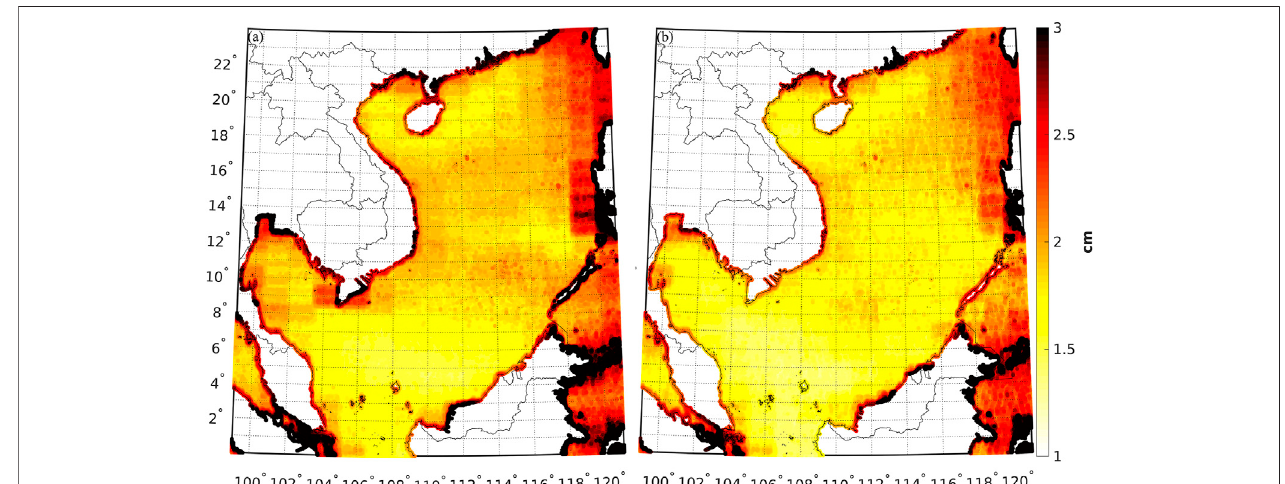
FIGURE 6 | Interpolation errors of (A) DTU15MSS, and (B) DTU18MSS over South China Sea.